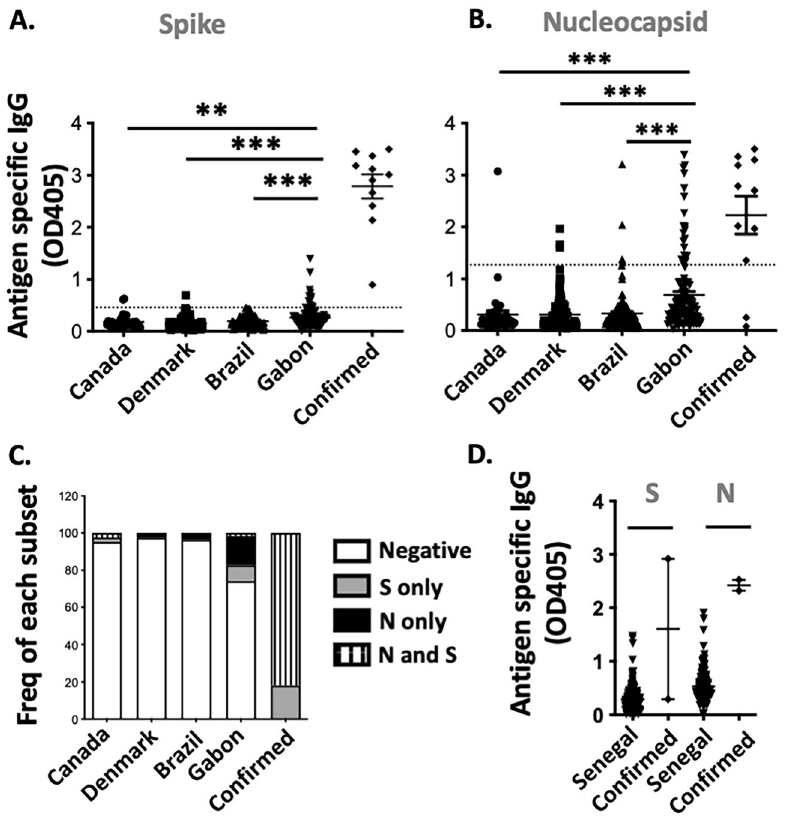
Figure 1. Pre-existing immunity against SARS-CoV-2 S and N protein in various populations. Serological screening for the presence of IgG against SARS-CoV-2 S ( A , D ) and N protein ( B , D ). Sera from Quebec (n = 41), Denmark (n = 117), Brazil (n = 108) and Gabon (n = 116), and 11 COVID-19 confirmed cases ( A , B ) as well as pre-pandemic (n = 128), and COVID-19 confirmed sera (n = 2), from Senegal ( D ) were analyzed by ELISA. The proportion of individuals with antibodies against either or both the SARS-CoV-2 S and N proteins is illustrated ( C